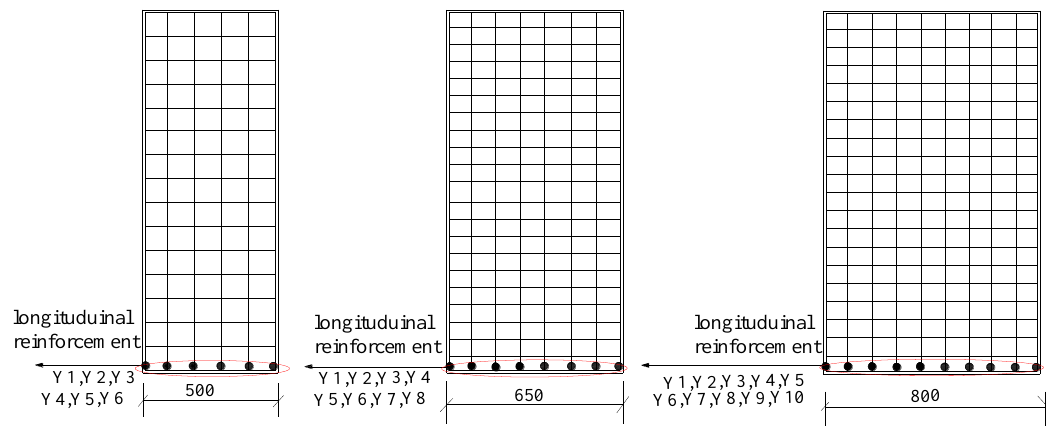
Figure 7. Arrangements of strain gauges of reinforcement in the flange.